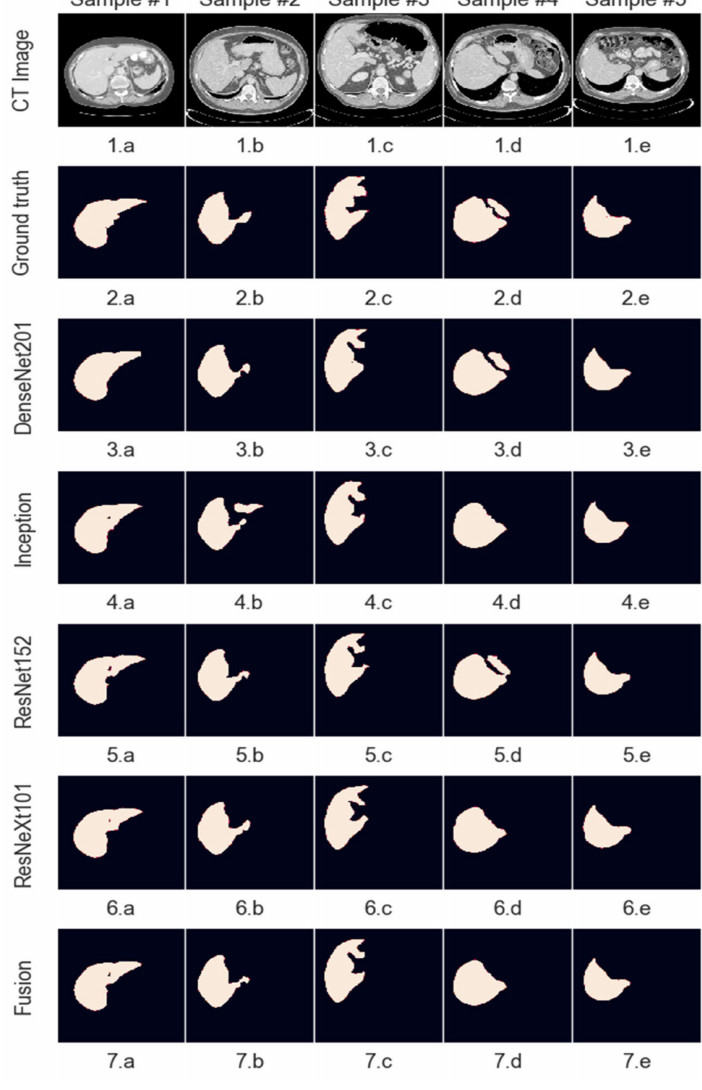
Figure 11. Sample liver